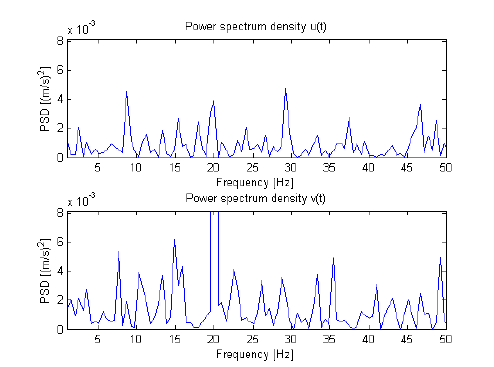
Fig. 9. Location of points under investigation.